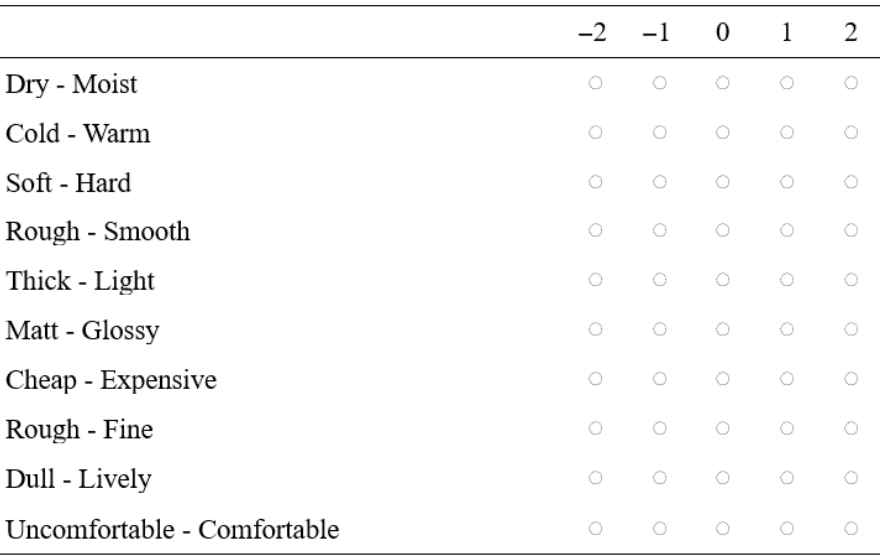
Figure 1. Cabinet material visual/tactile perceptual evaluation is on a sub-list.